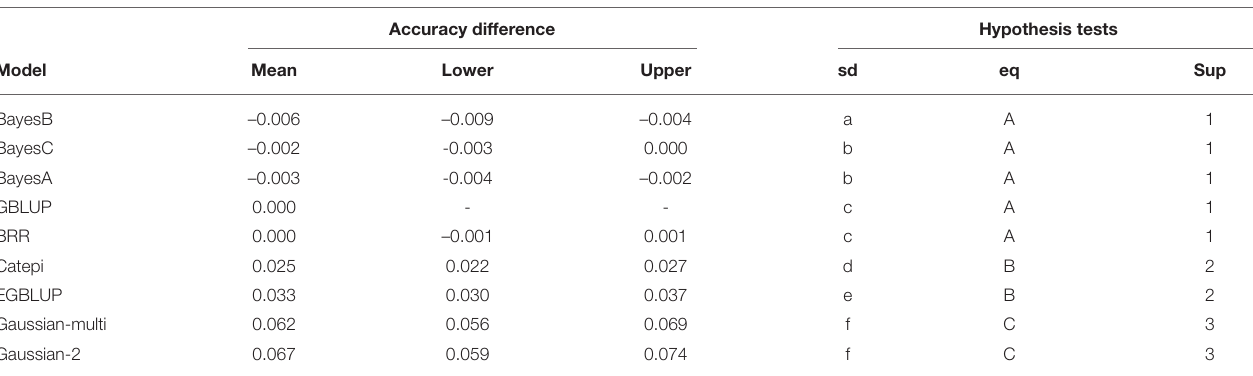
FIGURE 5 | Comparison of predictive accuracies across models for the trait 1 of the wheat dataset. Colors show a 3-group clustering of the models based on the accuracy with a hierarchical clustering on the right side. TABLE 1 | General model comparison for the wheat